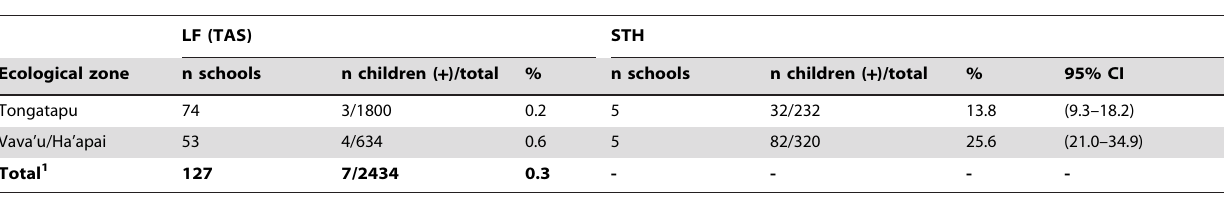
Table 6. Tonga TAS and STH survey results.